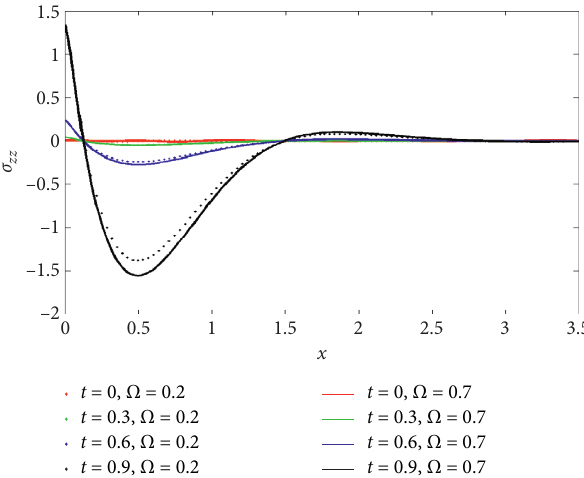
Figure 18: Horizontal displacement u concerning x with laser pulse “ t ” and rotation.